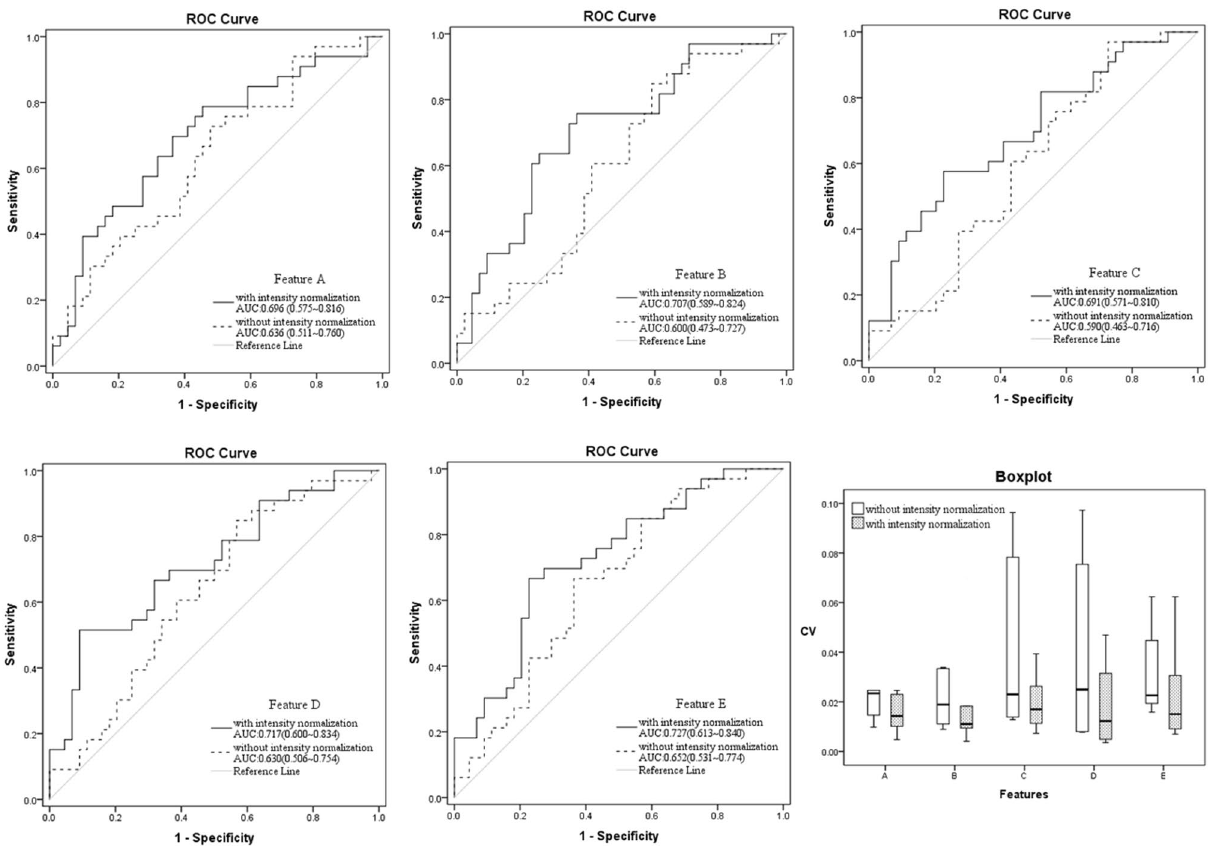
Figure 2. ROC curves and the boxplot. Note From ROC curves, all the area under the ROC curve values of these representative radiomics features in discriminating cervical junctional zone from outer muscular layer in leiomyoma patients were higher with intensity normalization than those without intensity normalization. And the boxplot showed that all the CV values were lower with intensity normalization than those without intensity normalization among these common representative radiomics features. Feature A: GLCMEntropy_angle90_ offset4; Feature B: GLCMEntropy_AllDirection_offset7; Feature C: GLCMEntropy_angle135_offset1; Feature D: RunLengthNonuniformity_angle90_offset1; Feature E: histogram